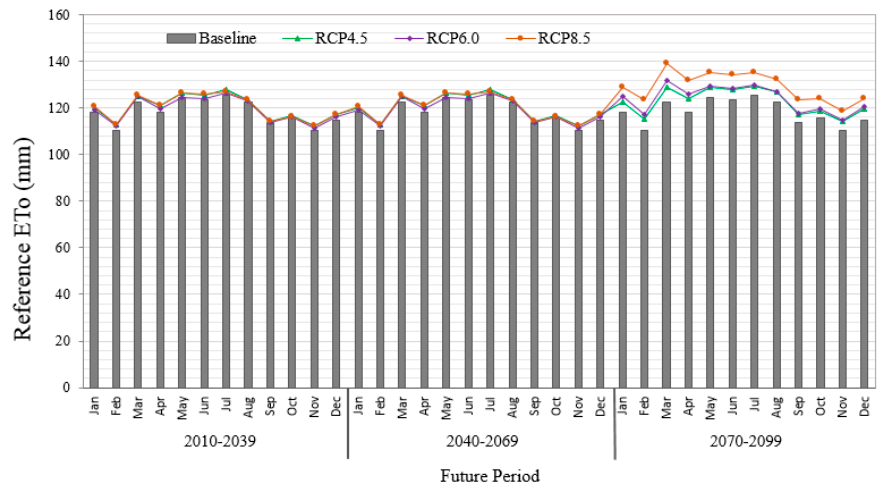
Figure 4. Projected mean monthly ensemble of multi-model reference evapotranspiration (ET 0 ) for RCP4.5, RCP6.0, and RCP8.5 scenarios and future periods of 2020s, 2050s, and 2080s compared to the baseline period.